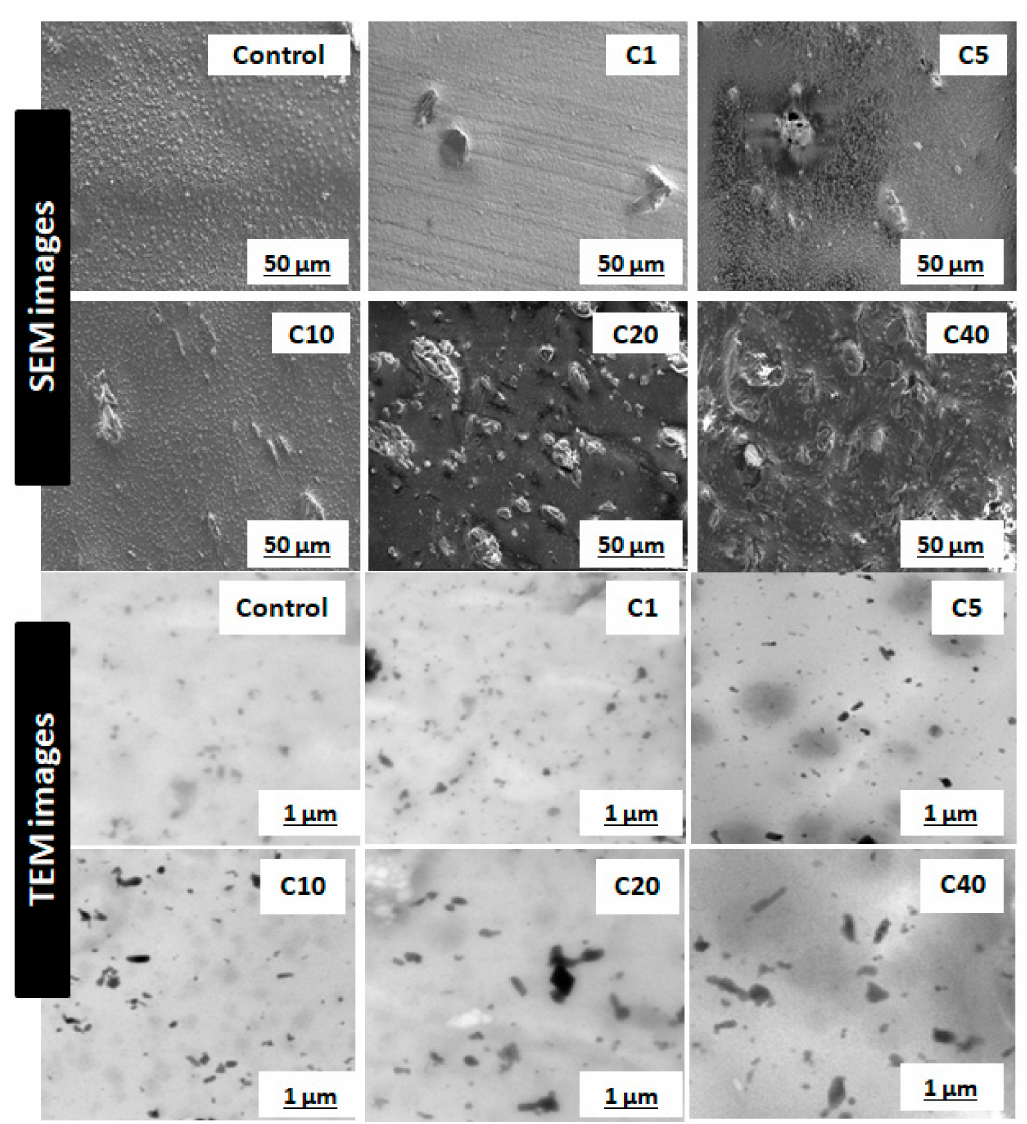
Figure 3. Scanning electron microscopy (SEM) images of cured stocks at 2500 × magnification; transmission electron microscopy (TEM) images of cured stocks at 8600 ×